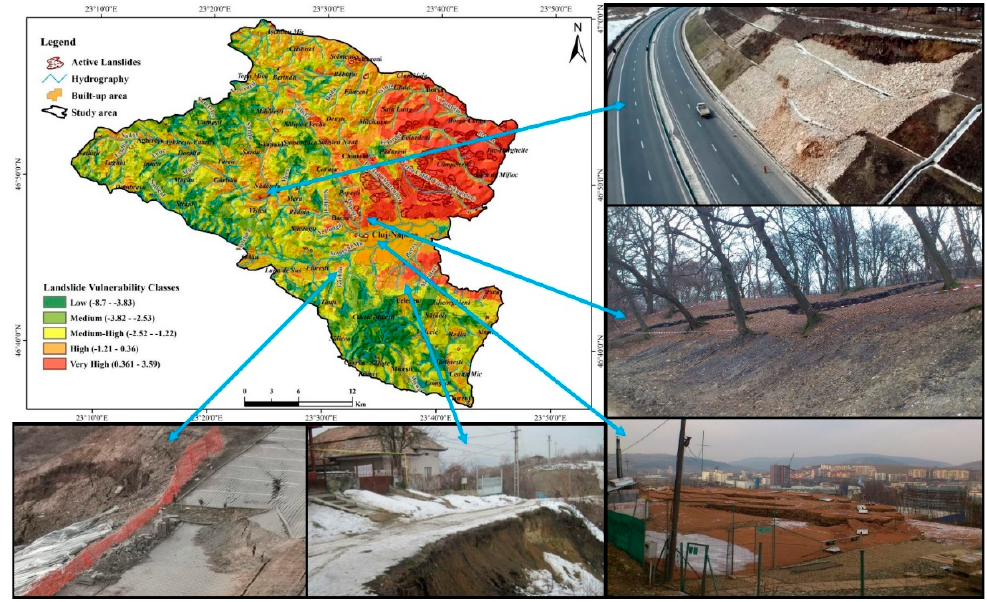
Figure 1. Landslide susceptibility map [4] with relevant hotspots. Landslides are natural disasters that occur worldwide, responsible for 9% of all ca- lamities [11], and are defined as the movement of soil, debris, and rocks under the influ- ence of gravity, with the largest occurrence in hilly and mountainous areas [12]. Accurate measurements of vertical and horizontal displacements are essential for forecasting future